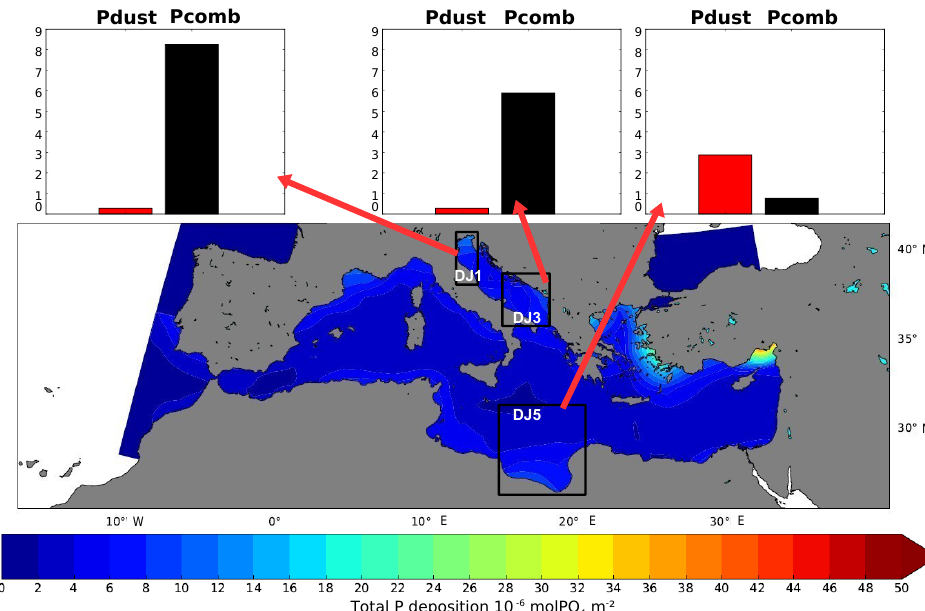
Figure 8. Map of total PO 4 deposition from both Pdust and Pcomb (10 − 6 molPO 4 m − 2 ) for June 2005. Red and black bars represent average PO 4 deposition (in 10 − 6 molPO 4 m − 2 ) from the two sources in each framed area. The limits of the areas are described in Manca et al. (2004) and Fig. 5. There is no atmospheric deposition modeled in the Marmara and Black